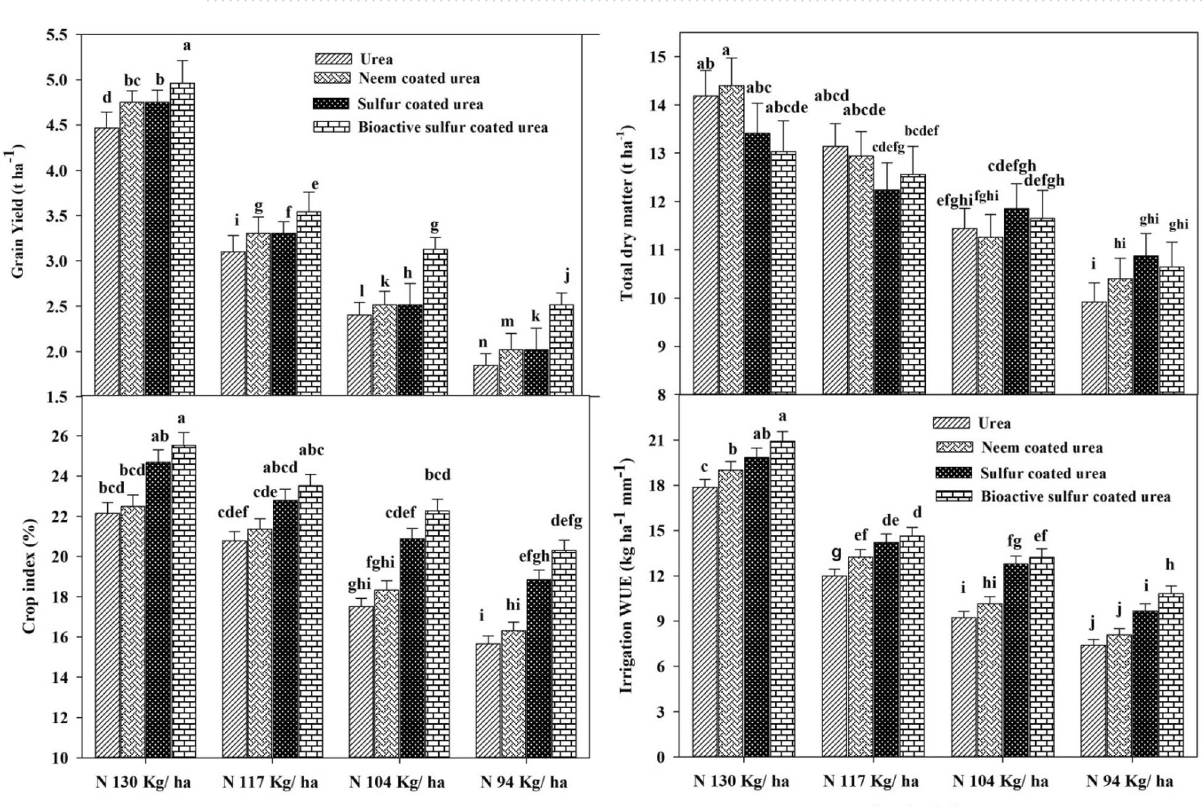
Figure 2. Effect of different slow release fertilizers and N rates on grain yield (t ha −1 ), total dry matter (t ha −1 ), crop index% and irrigation water use efficiency (kg ha −1 mm −1